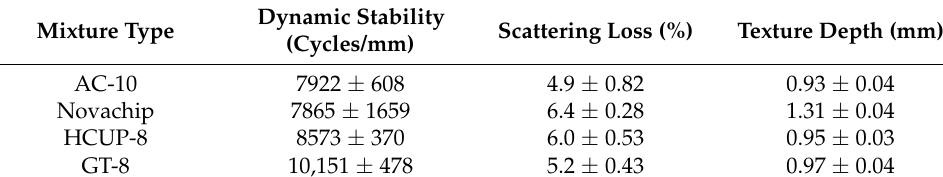
Table 10. Results of dynamic stability, scattering loss and texture depth.